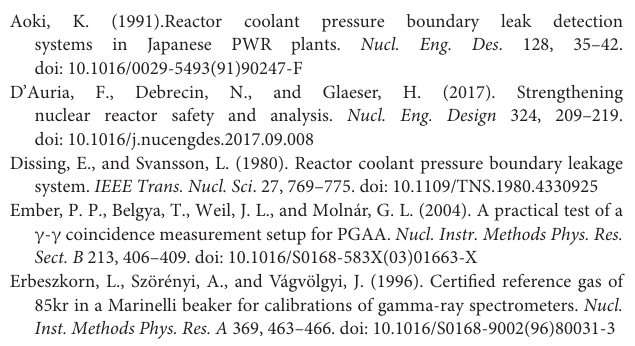
TABLE 3 | Coincidence efficiency and ε